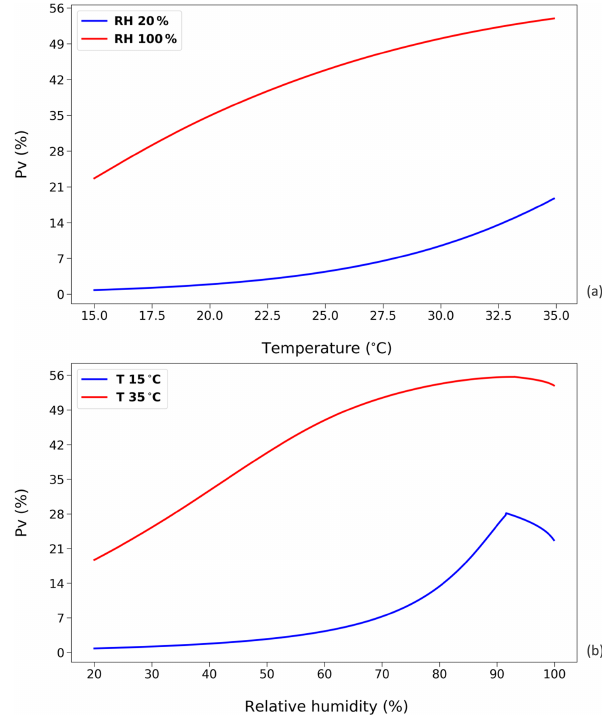
Figure 7. Curves that represent NH 3 volatilization rate ( P V ) for four different temperature and RH regimes based on annual ideal- ized simulations (see Fig. 6). (a) The NH 3 volatilization rate ( P V ) under dry (20% RH) and wet (100% RH) conditions, respectively. (b) The NH 3 volatilization rate ( P V ) under 15 and 35 ◦ C, respec- tively. (See Sect. 2.2.1; shown using the new parameterizations for temperature and